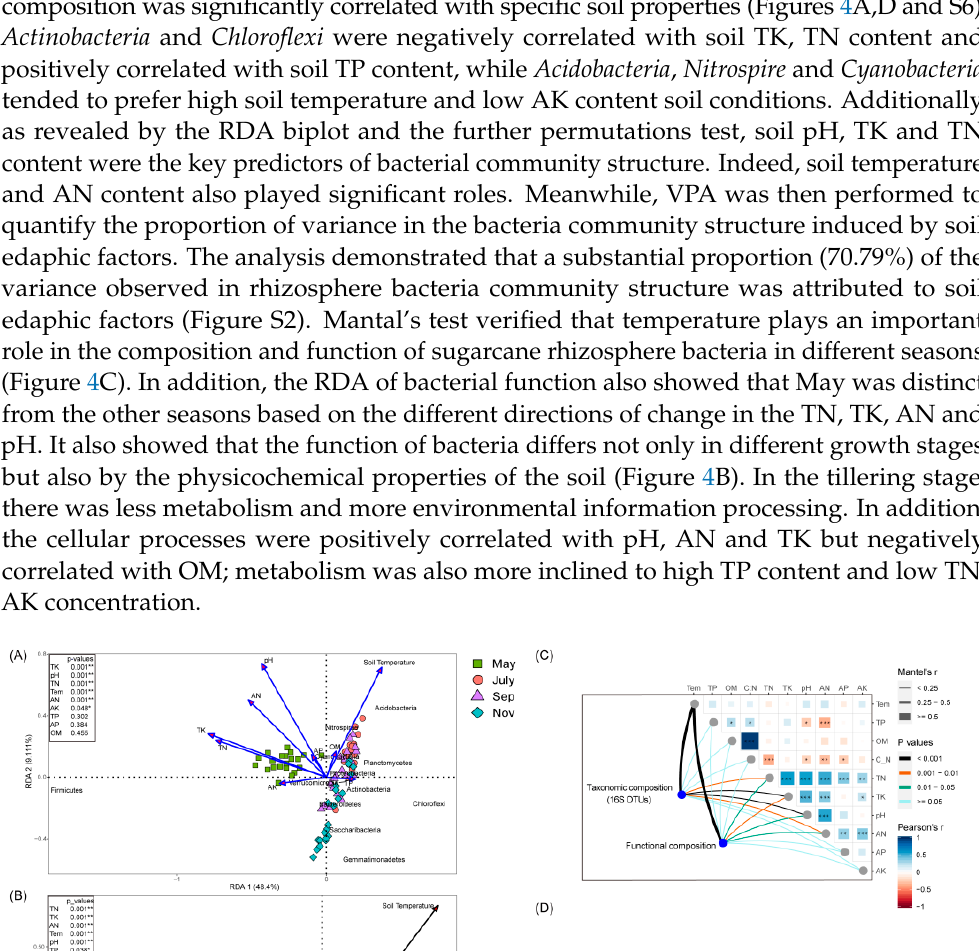
sampled in May, July, September and November. In the top-left, the soil soil edphic factors were fitted Figure 4. RDAs analysis between soil edaphic factors and bacteria phyla ( A ) and KEGG-L1 ( B ),